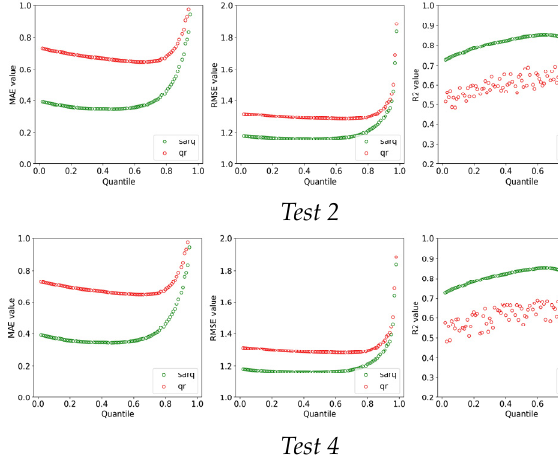
Figure A1. Model performance of total crash rate